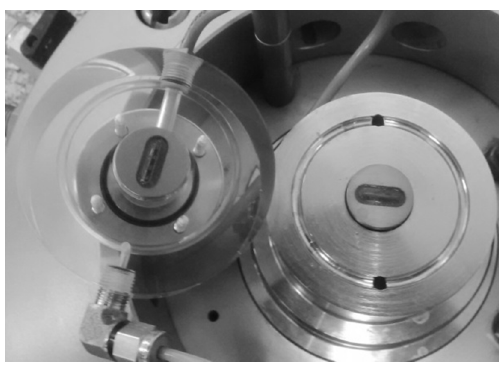
Figure 2. Bender element inserts mounted in a top cap and base pedestal.